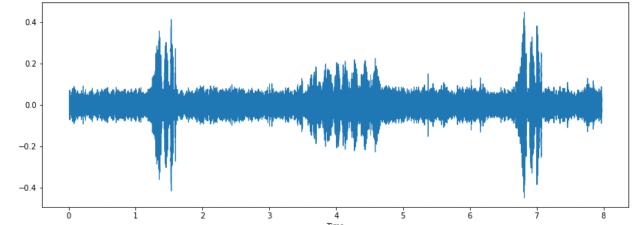
Figure 8: Accuracy of 70%